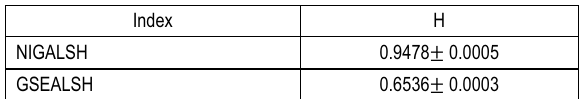
Table 3. The Hurst exponent of volatility with